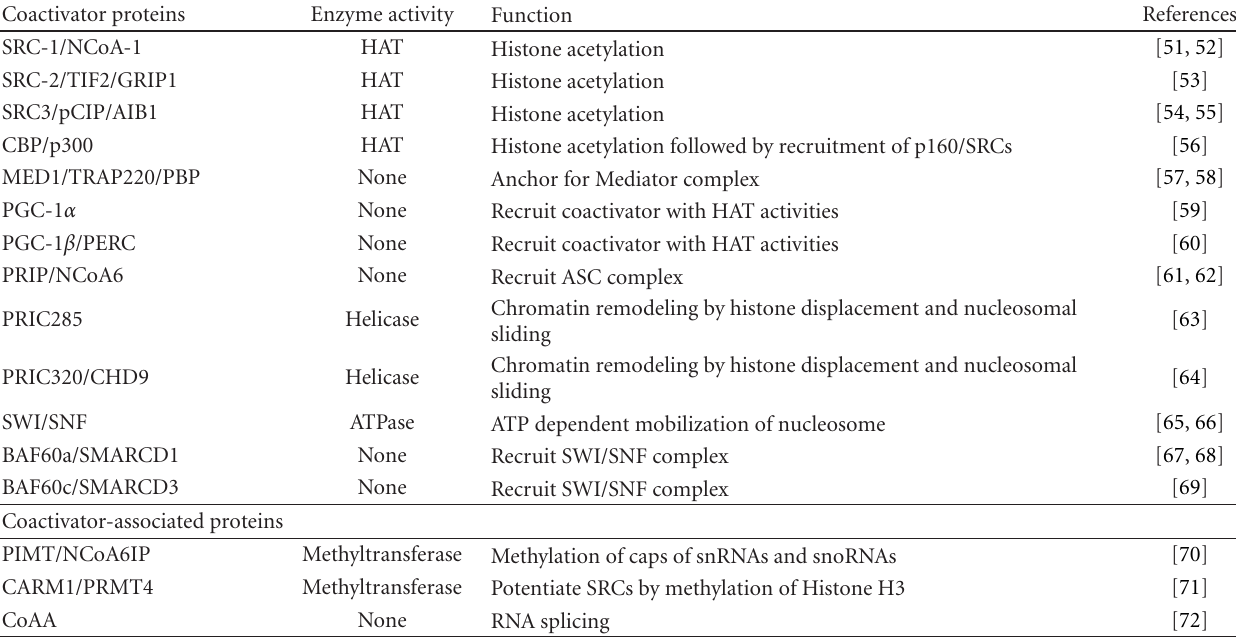
Table 1: Some known coactivator and coactivator associated proteins that regulate PPAR function. Coactivator